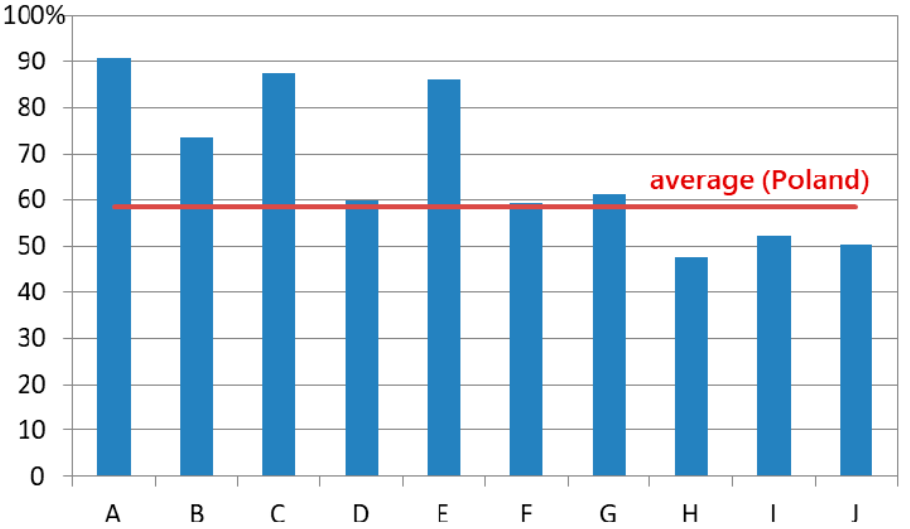
Figure 2. Share of municipalities in which references to RES existed in the existing spatial development conditions and directions.